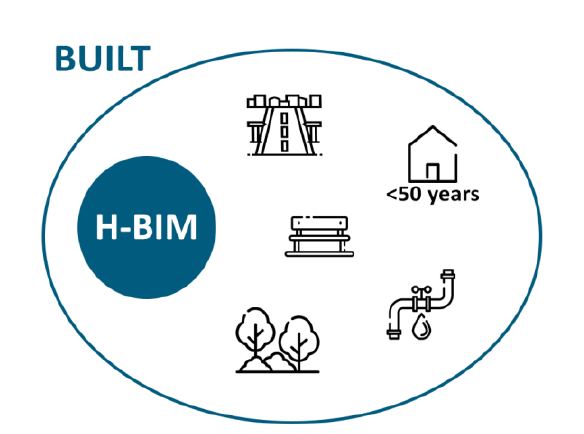
Figure 1. Scheme of the elements of the built